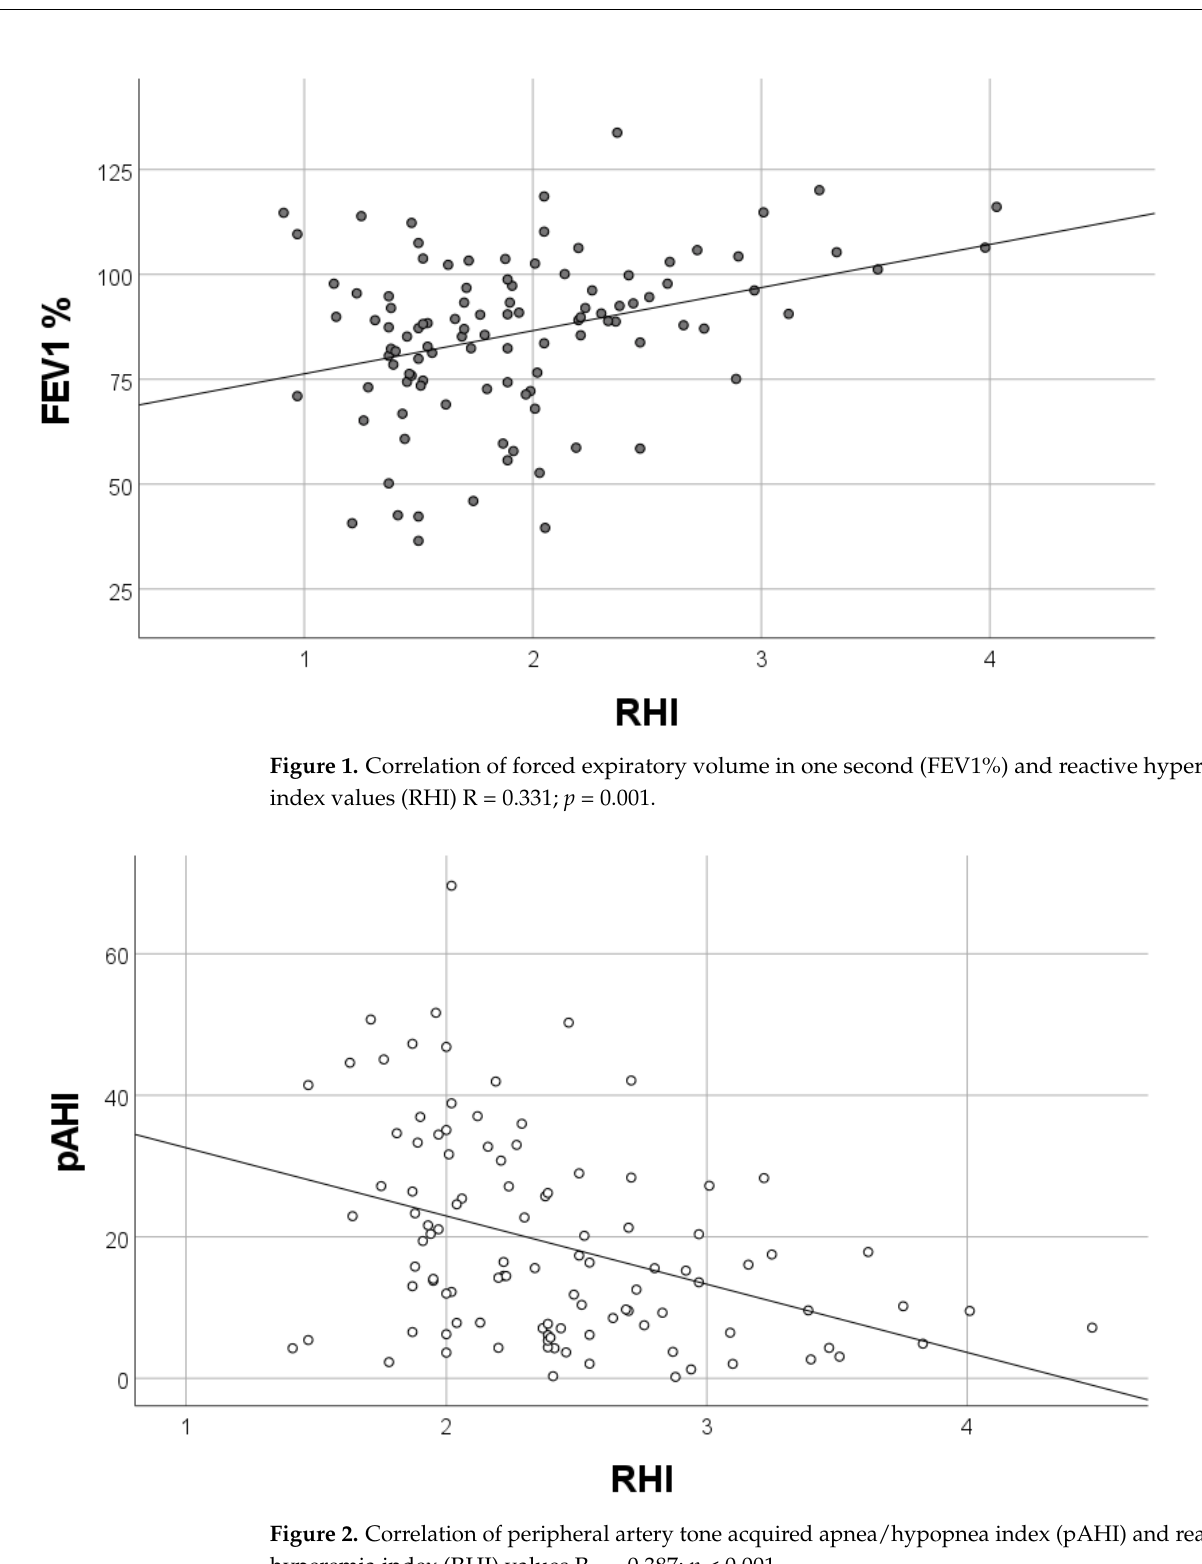
Figure 3. Correlation of baseline forced expiratory volume in one second (FEV1%) and peripheral artery tone acquired apnea/hypopnea index (pAHI) R= −0.280; p = 0.004. 4. Discussion This prospective registry of patients admitted for the diagnostic CAG showed that obstructive sleep apnea signs measured by WatchPAT: pRDI, pAHI and ODI were asso- ciated with endothelial dysfunction. Additionally, greater airflow limitation by spirome- try was detected in patients with endothelial dysfunction. Patients with endothelial dys- function showed an increase in left ventricular hypertrophy with a trend of increase in left atrial enlargement, indicating underlying diastolic dysfunction. However, the endothelial dysfunction was independent of the presence or severity of obstructive coronary artery disease in CAG. In the current study, pAHI during sleep was inversely correlated with